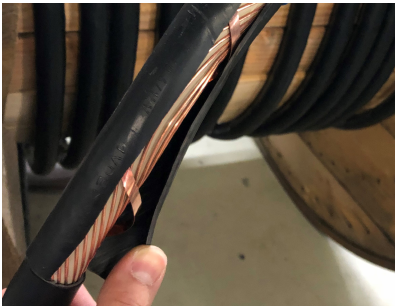
Figure 8. NAYCWY 4 × 50 SE/25 test cable (sheath cut